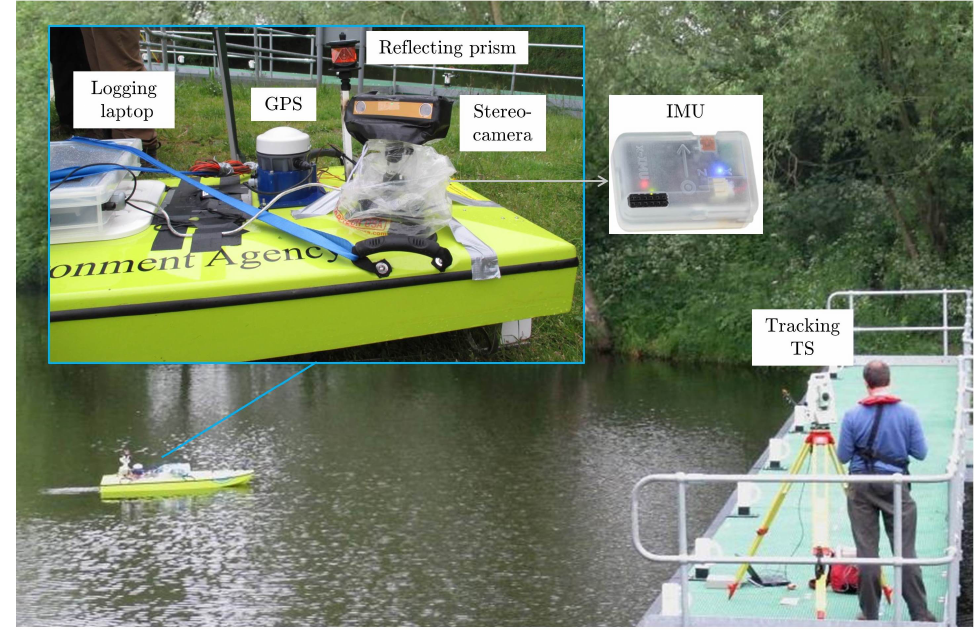
Figure 2. Technical data collection